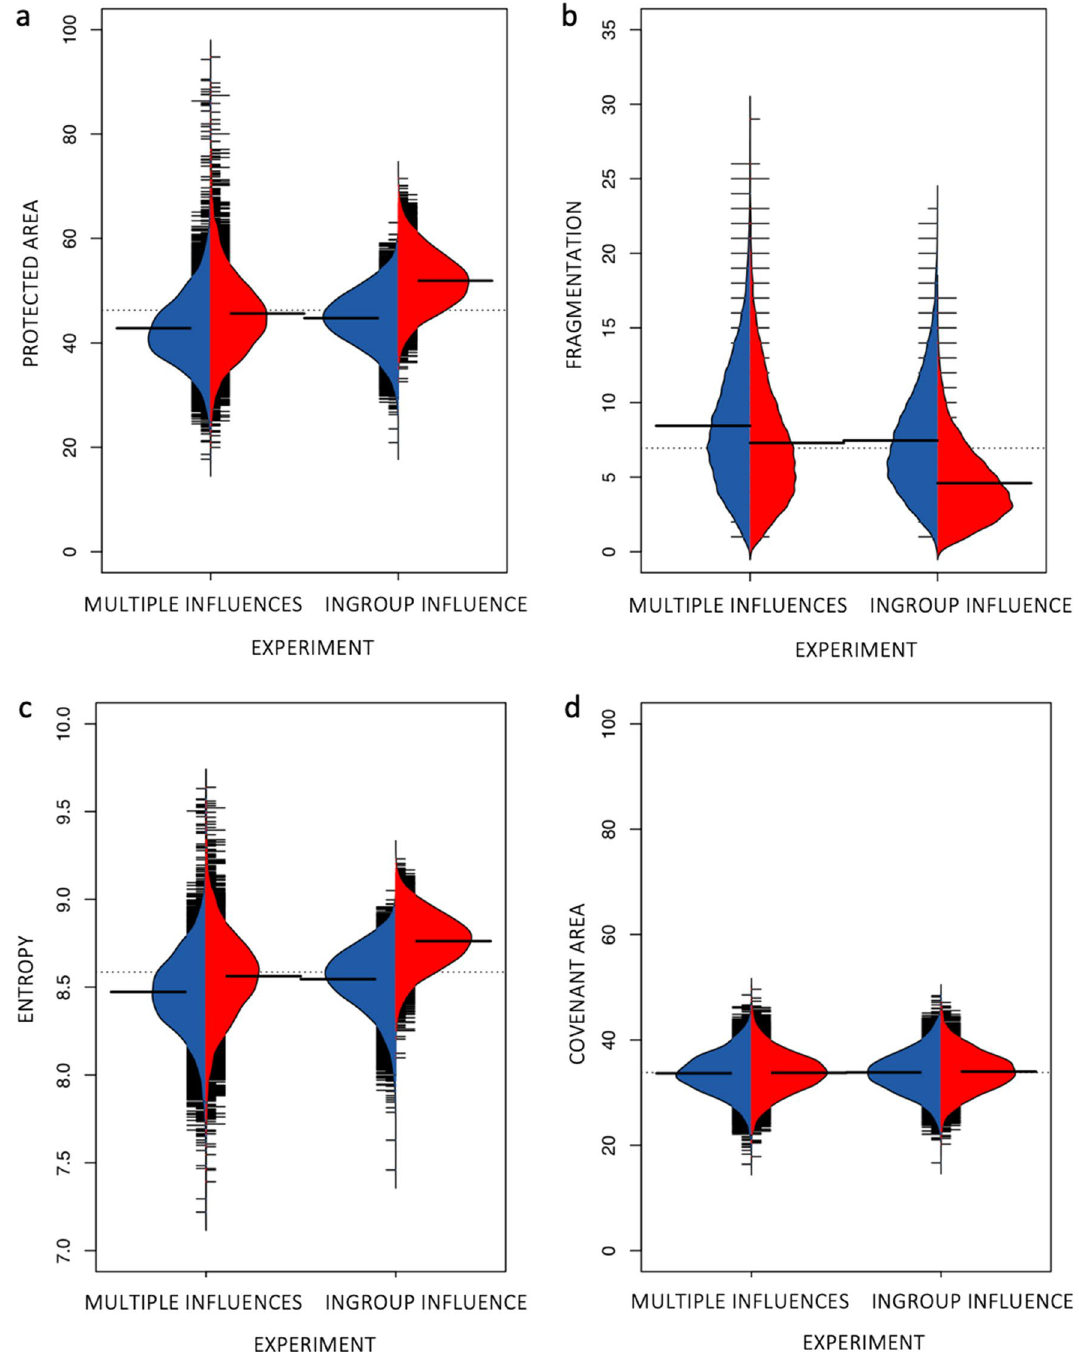
Figure 3. The main environmental outcomes for experiments including multiple social influences and peer influence only. The blue distributions present results for experiments using actor similarity-based network model, and the red distributions show results for experiments using ER model. Comparisons of experiment- specific outcomes are shown as bean plots. Horizontal black lines represent averages for experiment-specific distribution and dashed lines represent overall averages. ( a and d ) Show the total percentage of protected and covenanted area, respectively, of the land available for conservation in the modelled landscape. Fragmentation ( b ) represents the number of habitat fragments in the landscape and entropy the randomness of these fragments. The length of the bean per point found is 0.1. The high ends of the beans are cut to a maximum value of 0.2 for visibility of the distribution. The figure was produced using the Beanplot R package version 1.2 77,78